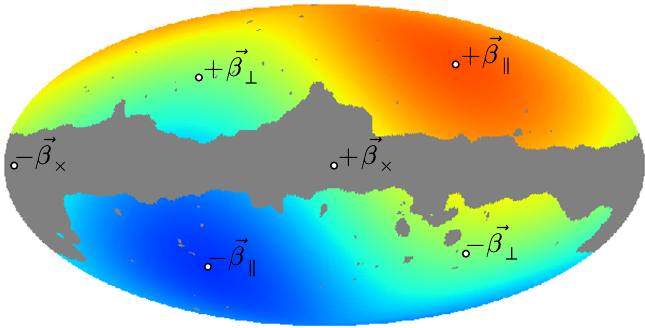
direction. The two k